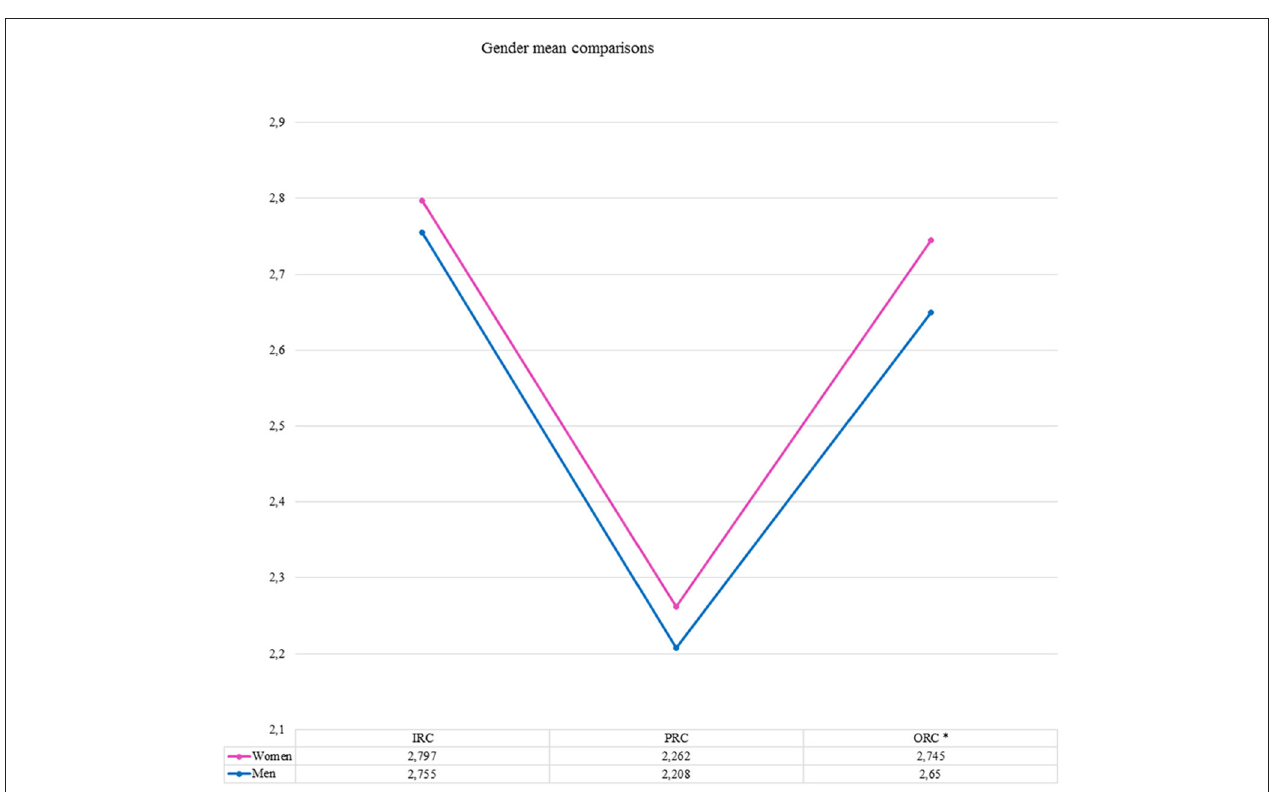
FIGURE 1 | Gender mean comparisons. *Significant at p < 0.001. Maximum score possible =